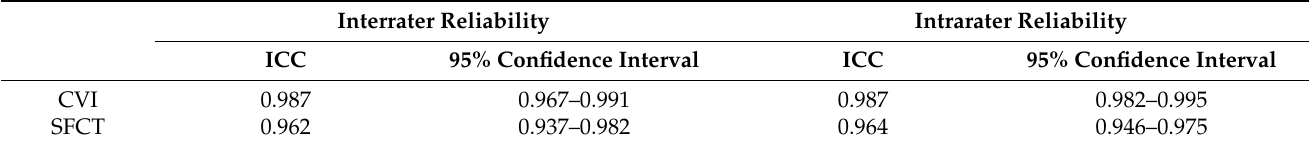
Table 6. Interrater and intrarater reliability assessment of CVI and SFCT